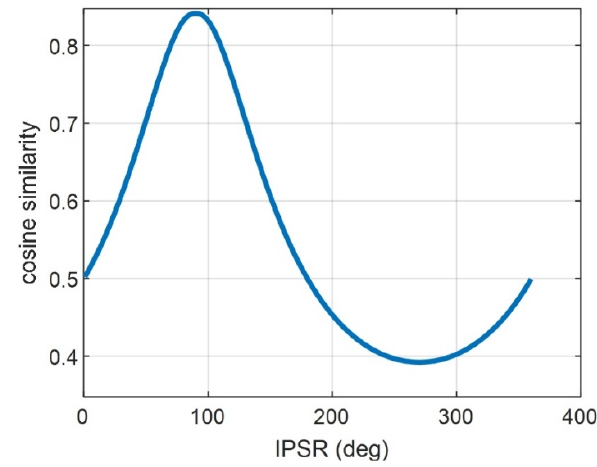
Figure 7. Cosine similarity with IPSR.